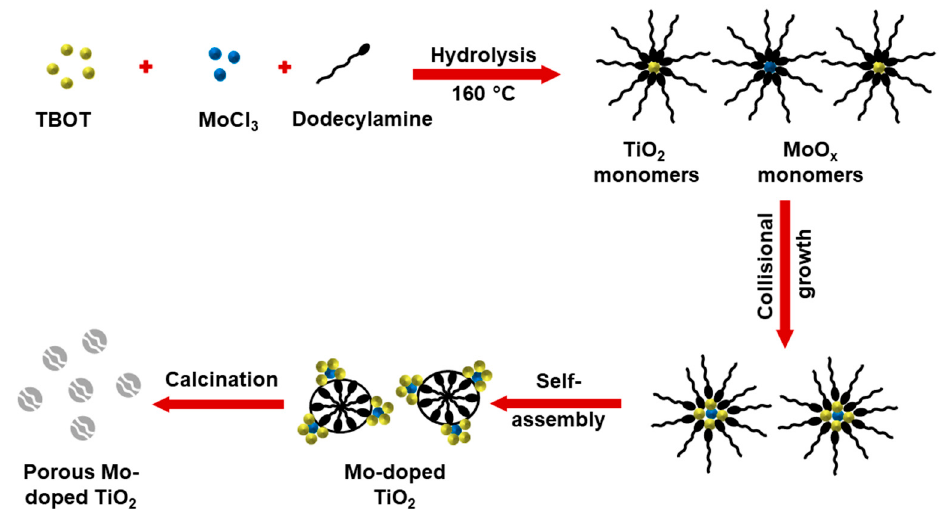
Scheme 2. Schematic diagram for the formation mechanism of Mo-TiO 2 .